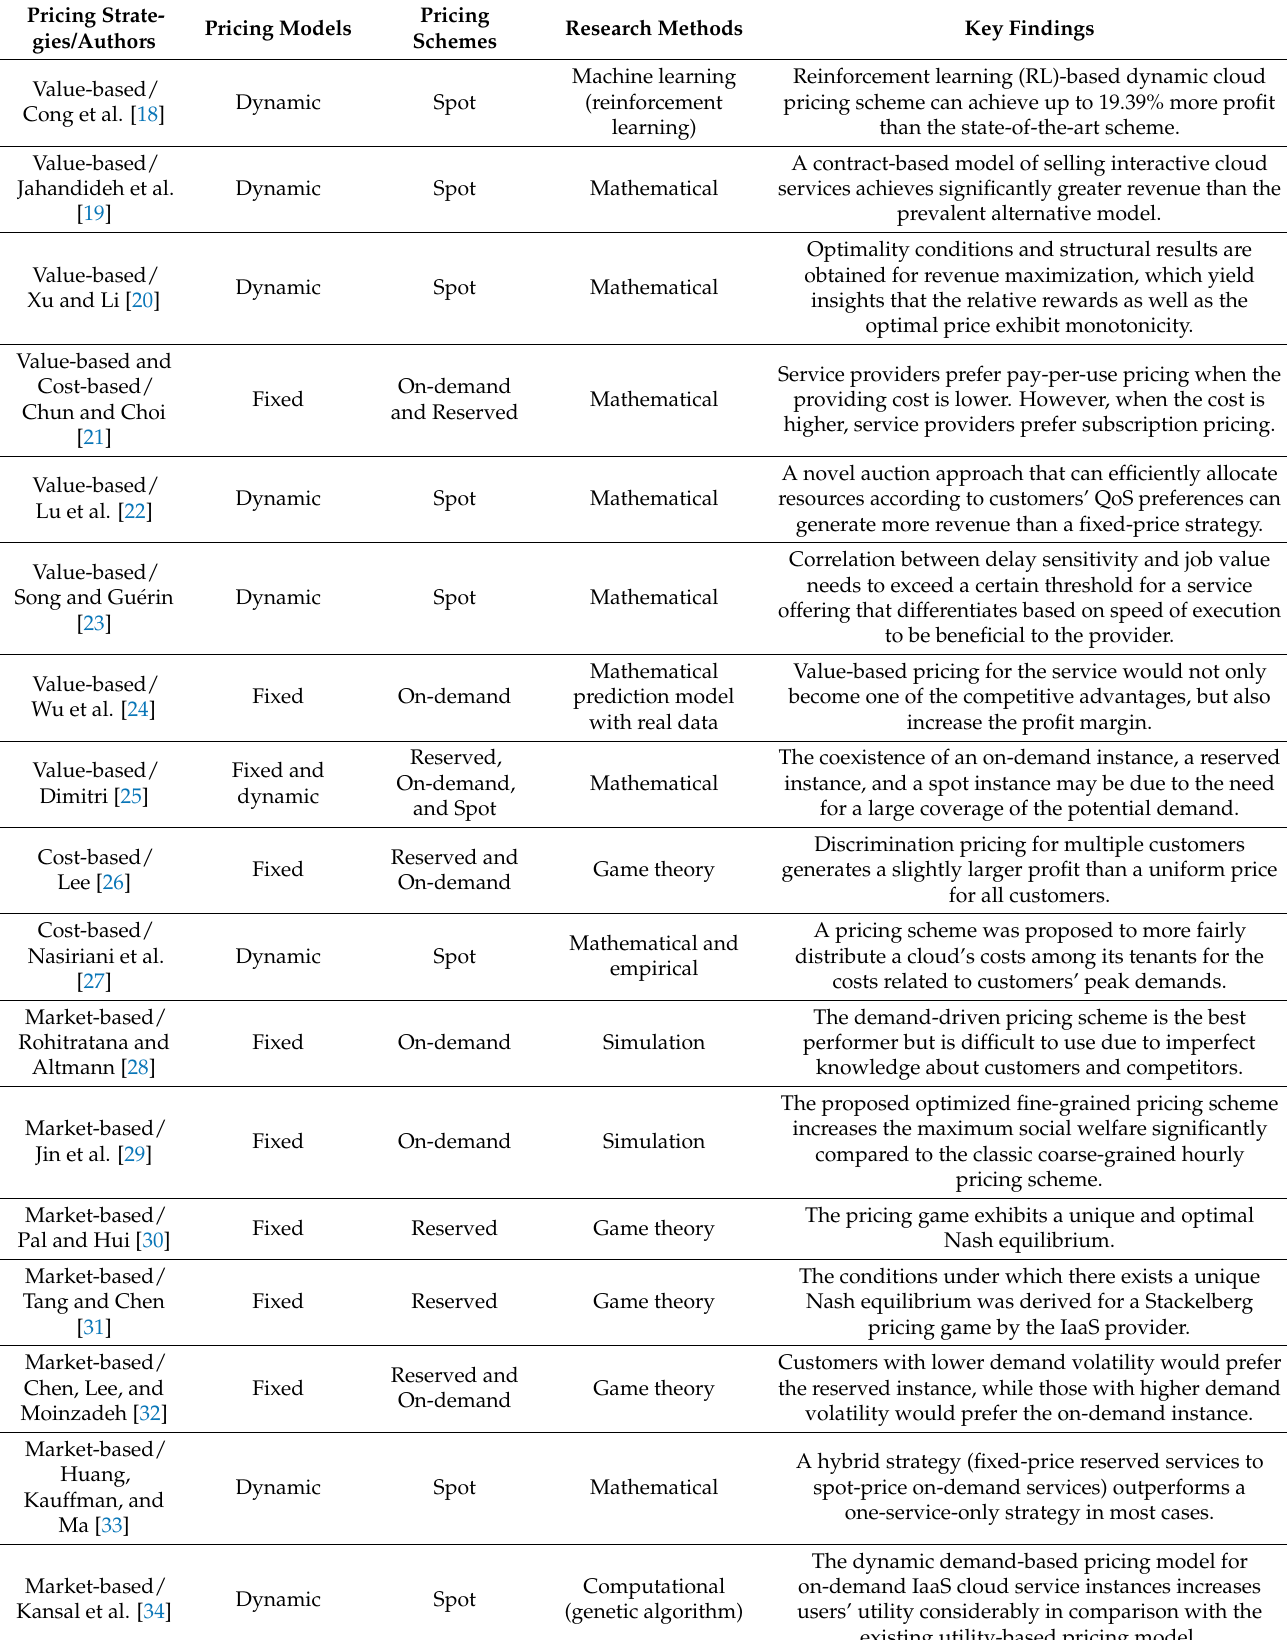
Table 1. Pricing Approaches, Pricing Models, Pricing Schemes, Research Methods, and Key Findings of Select